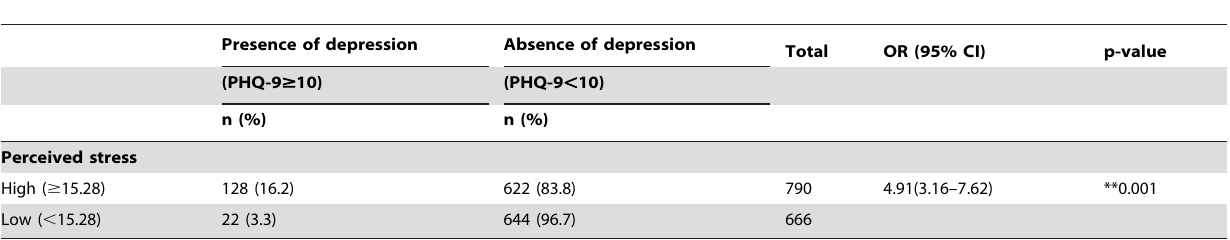
Table 5. Association of perceived stress with depression among participants (n=